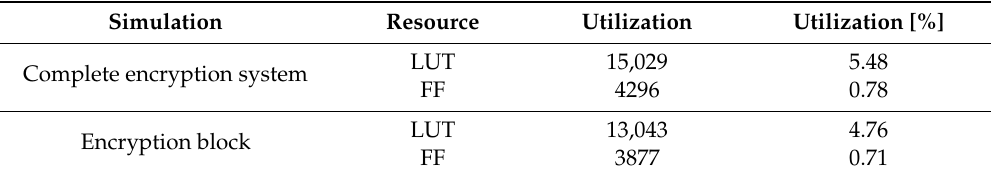
Table 1. Hardware resources utilization of the ZCU102 Field Programmable Gate Array (FPGA) platform related to the encryption algorithm; in particular, the complete encryption scheme, including all the blocks to test the correct operation of the algorithm and only the encryption block have been considered.